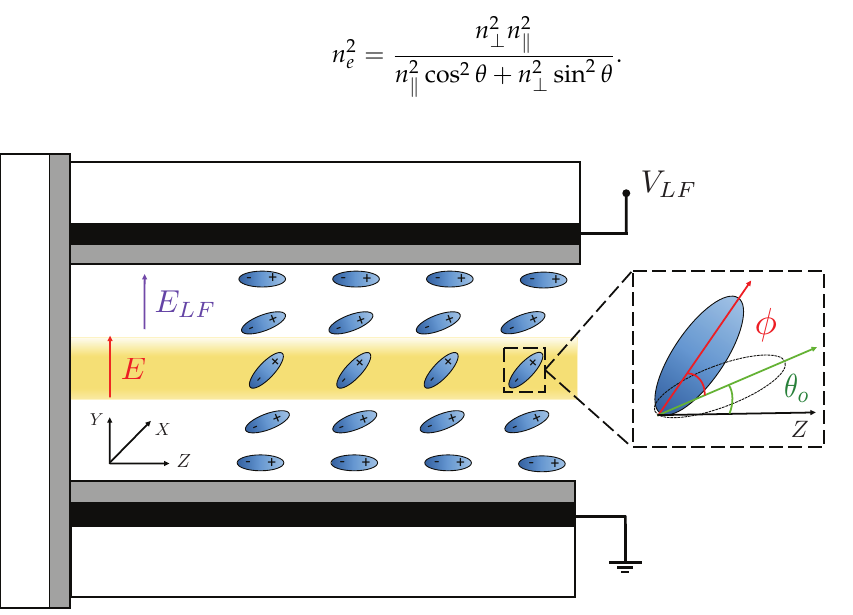
Figure 1. Sketch of nematic cell. A coherent light beam (yellow region) in which the electric field E is polarized in the Y direction propagates in the Z direction through a cell filled with a dye-doped nematic liquid crystal. Thin film electrodes (black) are deposited on the upper and lower cell walls (grey). An external low frequency voltage bias V LF creates an electric field E LF to pre-tilt the molecules at an angle θ 0 to Z . The nematic molecules which are located at the boundaries are held tightly by the virtue of the anchoring films. The far right inset (black) dashed box exhibits the angular rotation of a nematic molecule with respect to the propagation direction Z in the absence ( θ 0 ) and presence ( θ 0 + φ ) of the optical